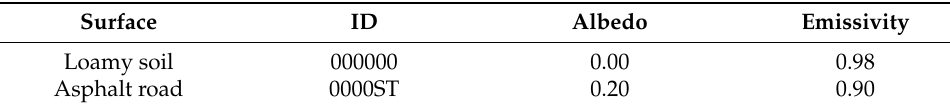
Table 5. Selected physical properties of surface.